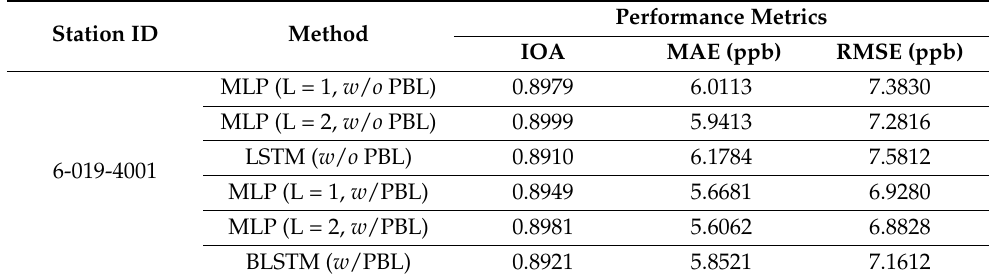
Table 3. Performance comparison of the MLP-based and bidirectional LSTM-based surface ozone forecasting models with and without the forecasted PBL heights in terms of IOA, MAE, and